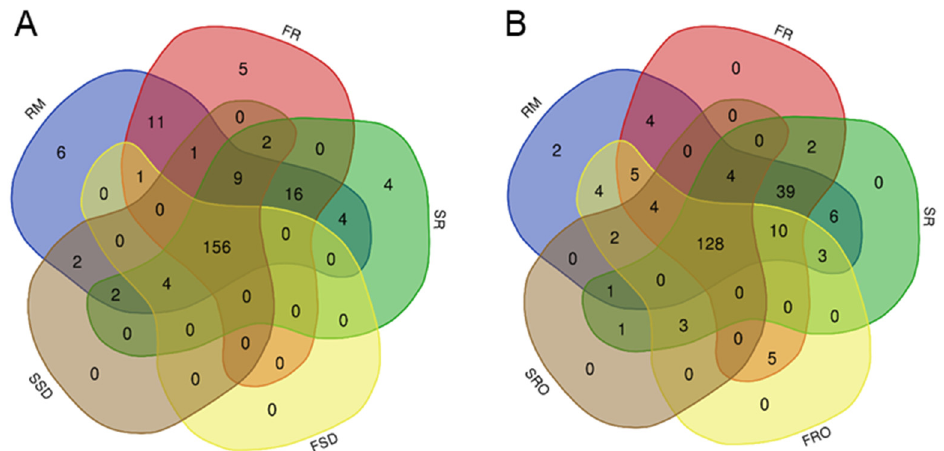
Figure 3. Venn diagrams of camel serum proteins identified in the spray-dewatering (SD) group ( A ) and reverse osmosis (RO) group ( B ). RM, raw milk; FR, freeze-dried raw milk powder; SR, spray-dried raw milk powder; FSD, spray-dewatering-concentrated/freeze-dried milk powder; SSD, spray-dewatering-concentrated/spray-dried milk powder; FRO, reverse-osmosis-concentrated/freeze-dried milk powder; SRO, reverse-osmosis-concentrated/spray-dried milk powder.